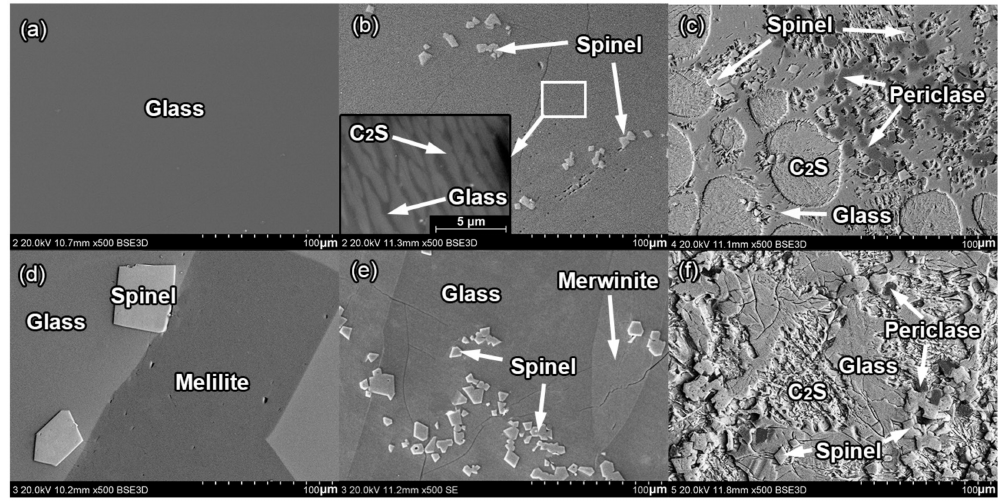
Figure 3. SEM-EDS results of S1, S2, and S3 quenched at 1600 and 1300 ◦ C. ( a ) B = 1.0, 1600 ◦ C;